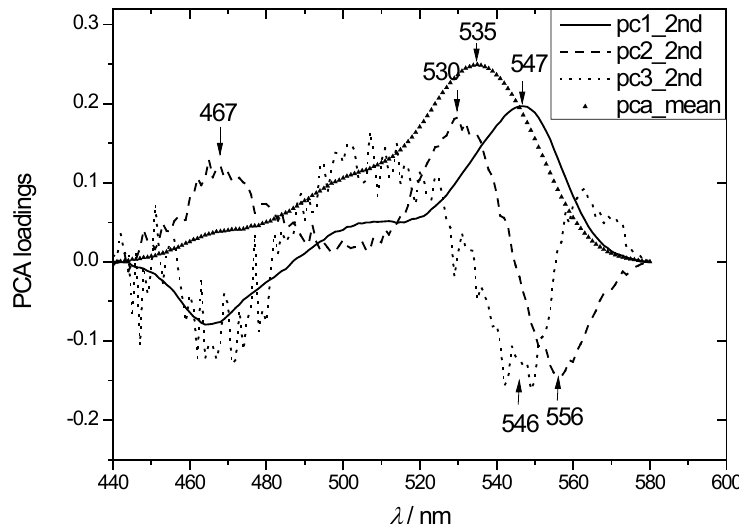
Figure 4. Loadings of principal components obtained by PCA using the spectra series measured at 20ºC for the second stage of the